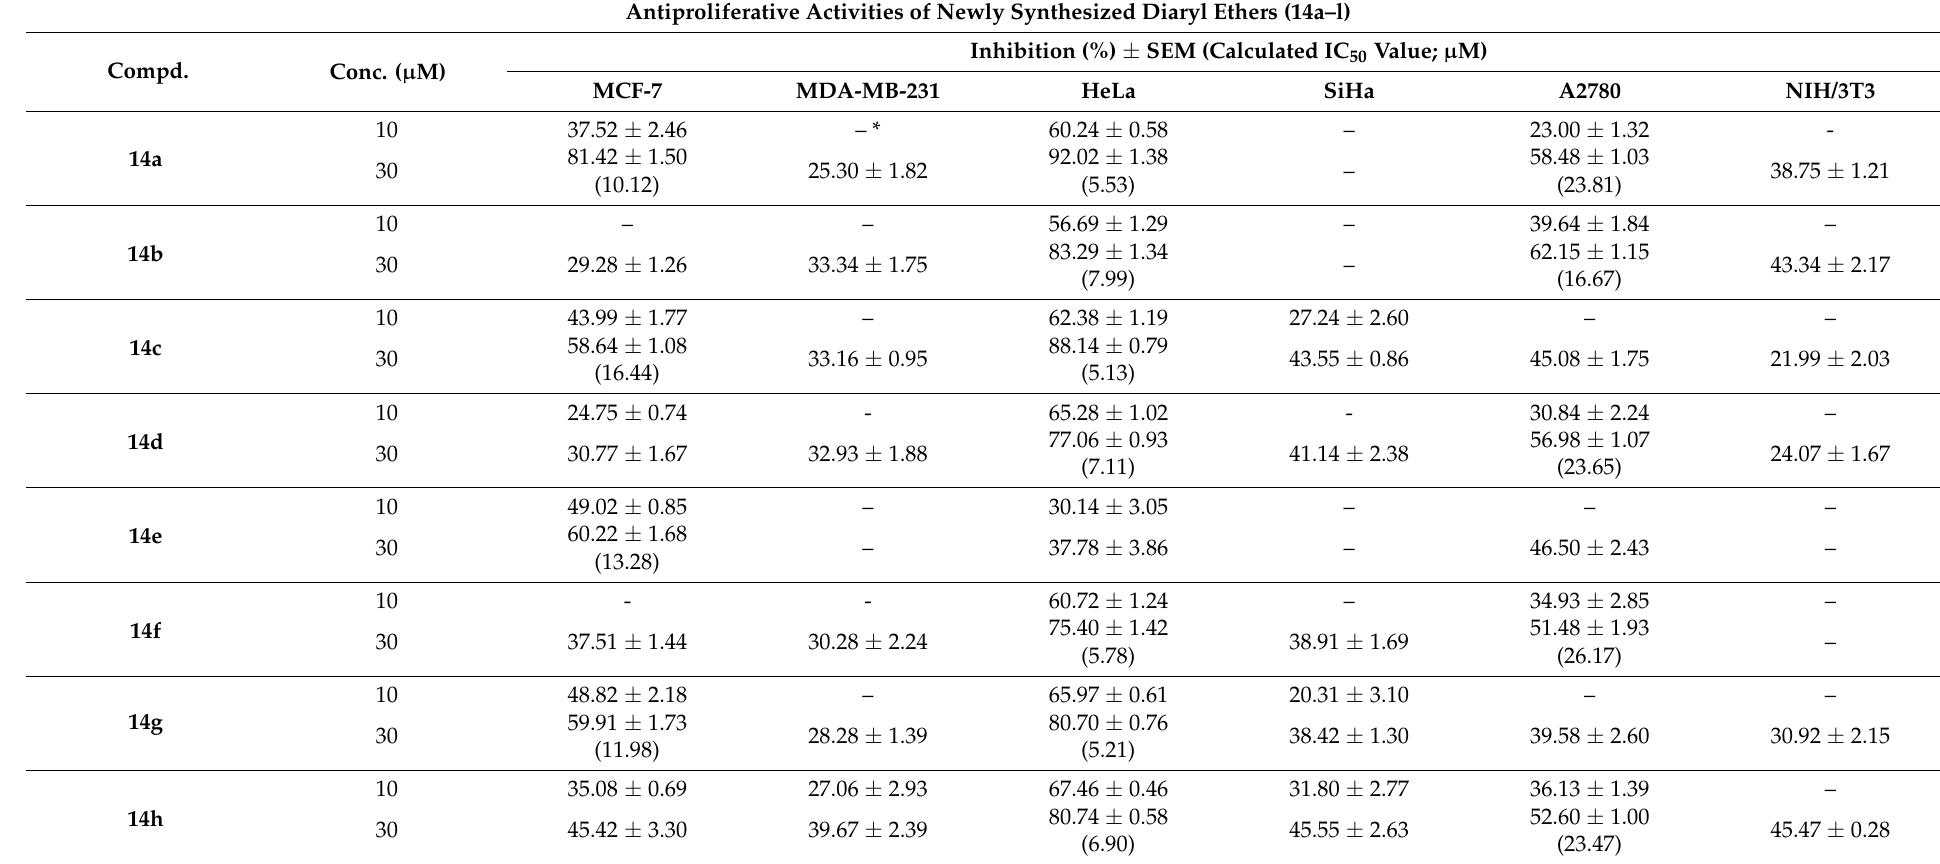
Table 1. Antiproliferative activities of newly synthesized diaryl ethers ( 14a – l